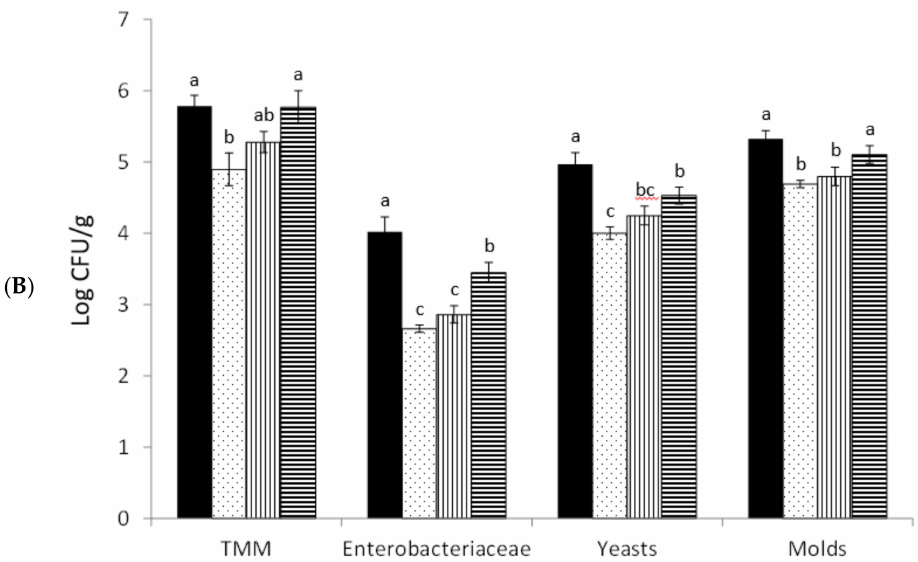
Figure 6. Microbial loads of aromatic herbs subjected to drying. ( A ), sage; ( B ),